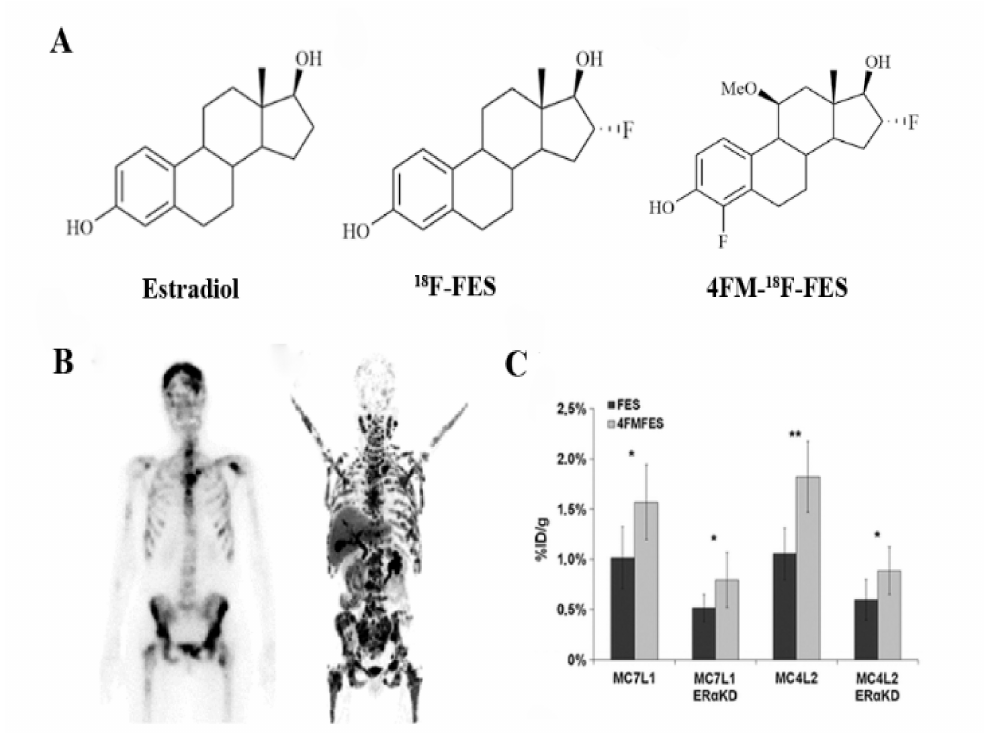
Figure 5. ( A ) chemical structure of ER α receptor probes marked by 18 F. Estradiol (E2), 18 F-FES, and 4FM- 18 F-FES; ( B ) image of the bone scan (left) and 18 F-FES PET (right) of a patient after multiple lines of anti-hormonal therapy and chemotherapy [172]; ( C ) biodistribution data of MC7-L1 and MC4-L2 (ER+ and ER α KD, respectively) tumor uptake for FES and 4FM- 18 F-FES [169]. * p < 0.05; ** p <